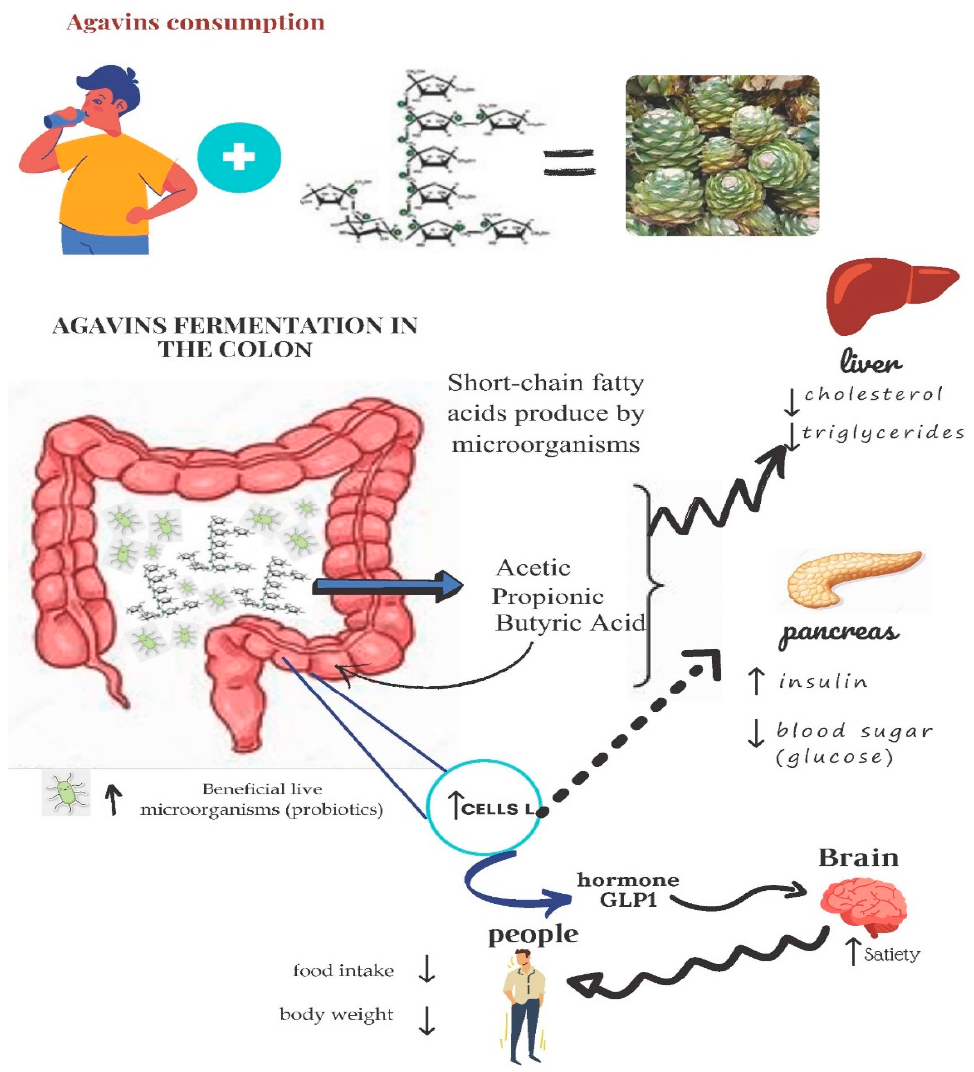
Figure 2. Mechanism by which agavine consumption can generate beneficial effects on health (adapted from [56]).